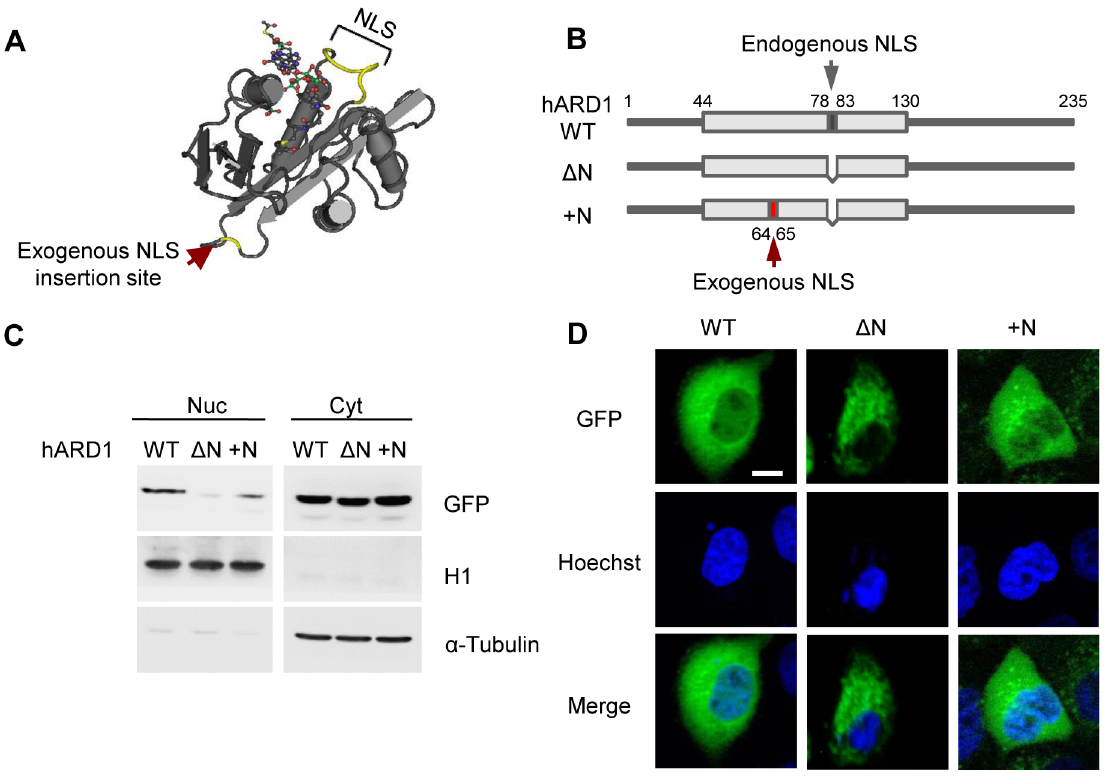
Figure 5. An exogenous NLS can rescue the nuclear localization of the hARD1 NLS mutant. A . The region of the exogenous NLS insertion in ARD1. On the reported structure of the yeast ARD1, the region corresponding to the exogenous NLS insertion site in hARD1 (next to a.a. 64) is indicated by a red arrow. B . Schematic presentation of an exogenous NLS insertion to the NLS deletion mutant of hARD1. The NLS of hARD1, KRSHRR, was inserted next to a.a. 64 of the NLS deletion mutant (GFP-hARD1 + N). C . Insertion of NLS into hARD1 rescued the nuclear localization of the NLS deletion mutant. GFP-hARD1 WT, D N, and + N were transfected into HEK293T cells, and the localization of hARD1 was analyzed by nuclear/cytosolic fractionation. Note the slightly smaller size of D N recovered in + N. D . An exogenous NLS can redirect the hARD1 NLS mutant into the nuclei. GFP- hARD1 WT-, D N-, and + N-expressing HeLa cells were visualized under fluorescence microscopy. Scale bar, 10 m m.